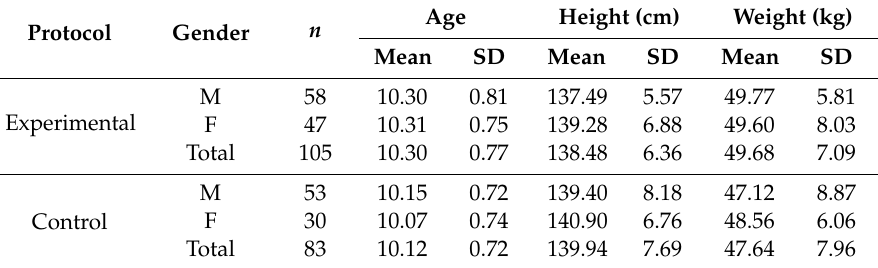
Table 1. Descriptive characteristics of the